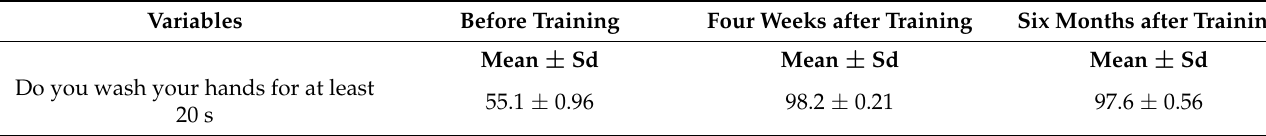
Table 4. Behaviour of food handlers before and after the